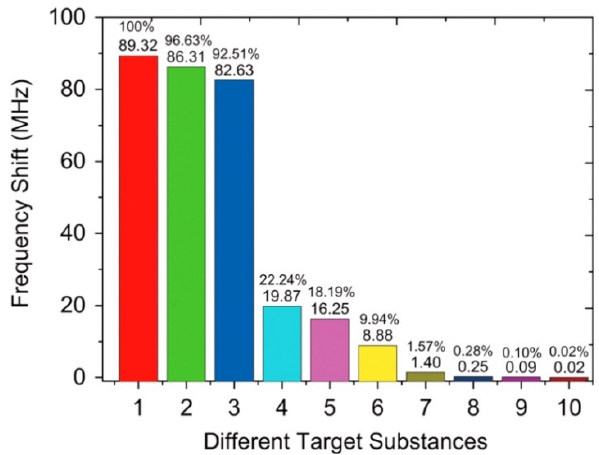
Figure 6. Comparison of SAW frequency shifts for different targets. Here, 1 is the response of target DNA (1 µg/mL) having 15 bases, 2 is the response of non-target DNA (1 µg/mL) having 15 bases with one mismatch base, 3 is the response of non-target DNA (1 µg/mL) having 15 bases with two mismatch bases, 4 is the response of non-target DNA (1 µg/mL) having only 4 bases, 5 is the response of non-target DNA (1 µg/mL) having only 3 bases, 6 is the response of target DNA (100 ng/mL) having 15 bases, 7 is the response of target DNA (10 ng/mL) having 15 bases, 8 is the response of target DNA (1 ng/mL) having 15 bases, 9 is the response for BSA, 10 is the response for PBS buffer, adapted with permission from [156].